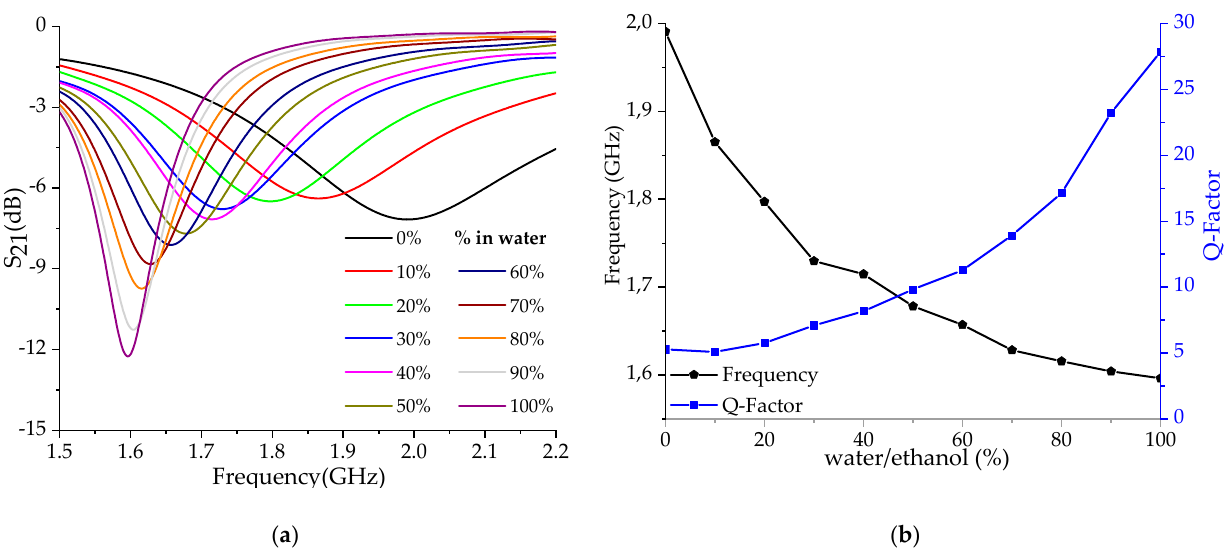
Figure 3. CST simulations of the flat sensor: ( a ) S 21 parameter and ( b ) Q factor of mixtures with different water–ethanol concentrations for the proposed sensor, with test glass radius r = 3.75 mm.